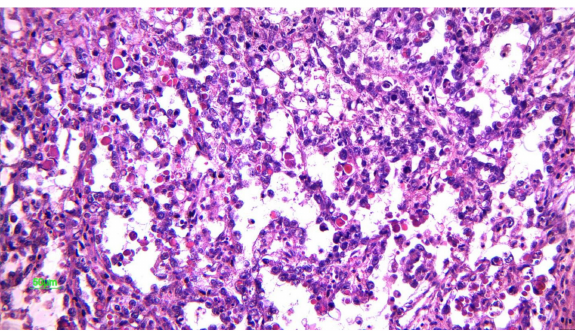
Figure 9. Anastomosing channels and variably sized cysts lined by neoplastic cells with clear and eosinophilic cytoplasm—eosinophilic hyaline droplets in the cysts (20 × HE). (Courtesy of Dr. R. Chirculescu).